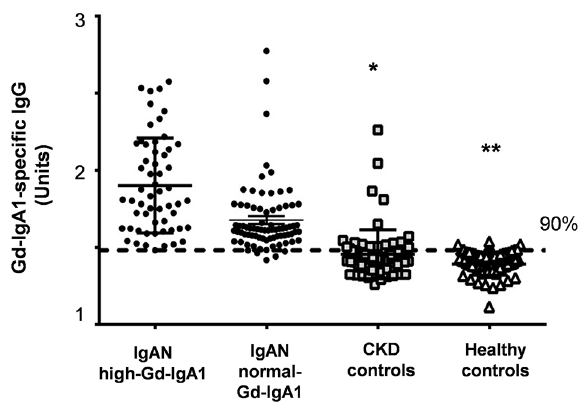
Figure 2. Serum levels of Gd-IgA1-specific IgG in IgAN patients with high-Gd-IgA1 or normal-Gd-IgA1 in comparison to CKD and healthy controls. We divided IgAN patients into two subgroups: patients with serum levels of Gd-IgA1 $ the 90 th percentile for healthy controls (high-Gd-IgA1 group; n=56) and patients with levels Gd-IgA1 , the 90 th percentile for healthy controls (normal-Gd-IgA1 group; n=79). Although serum levels of Gd-IgA1-specific IgG were significantly higher in IgAN patients with high Gd-IgA1 levels ( vs. CKD controls; *P , 0.0001, vs. healthy controls; **P , 0.0001), IgAN patients with normal Gd- IgA1 levels also had elevated Gd-IgA1-specific IgG ( vs. CKD controls; *P , 0.0001, vs. healthy controls; **P , 0.0001).